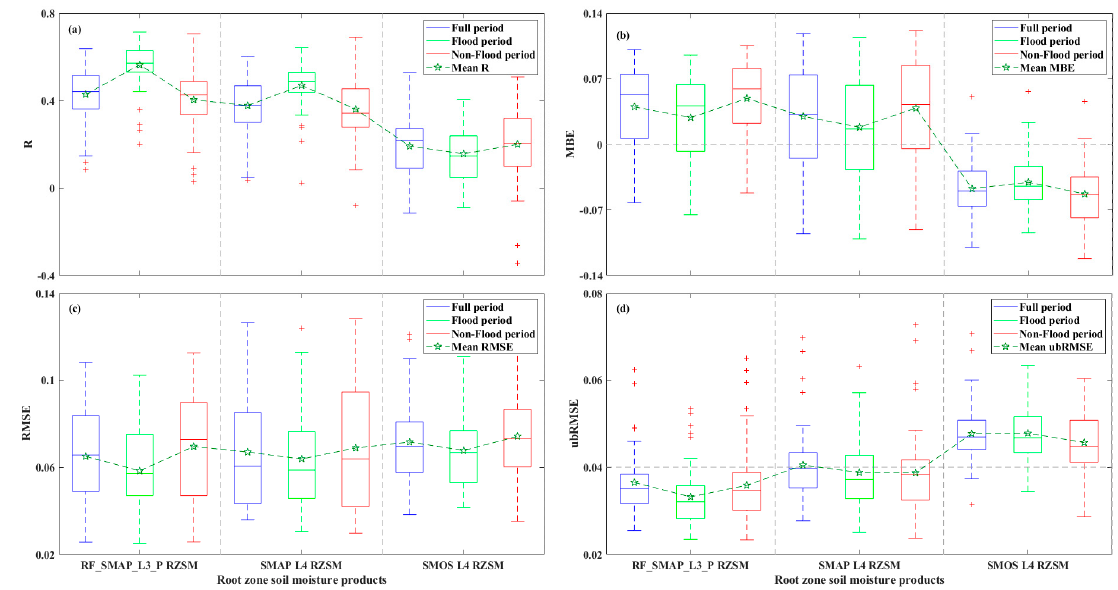
Figure 13. Boxplots of evaluation metrics (R: ( a ); MBE: ( b ); RMSE: ( c ); ubRMSE: ( d )) between model RZSM and in situ measurements in different periods. “+” represent outliers of T opt